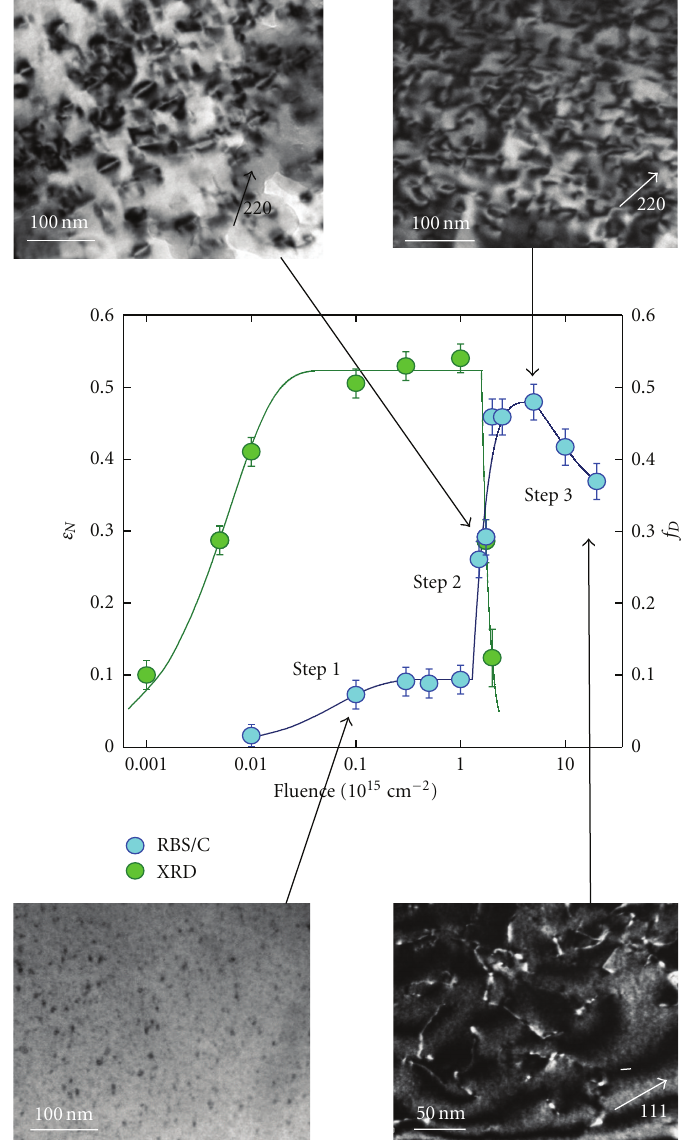
Figure 4: Accumulated damage ( f D ) and elastic strain ( ε N ) versus ion fluence for cubic zirconia crystals irradiated at RT with 4-MeV Au ions. Solid lines are fits to data using the MSDA model [23, 24]. Insets show TEM micrographs on samples irradiated at fluences indicated by the